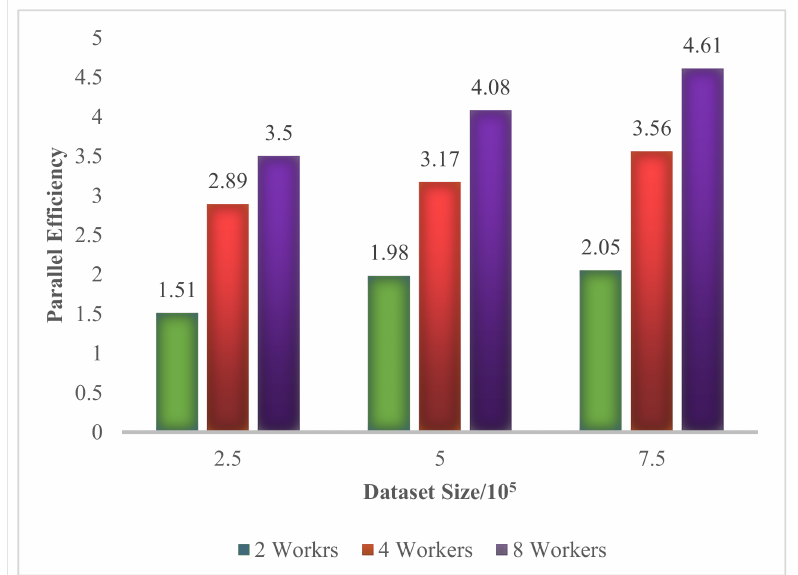
Figure 8. Algorithm parallel efficiency under different dataset sizes.